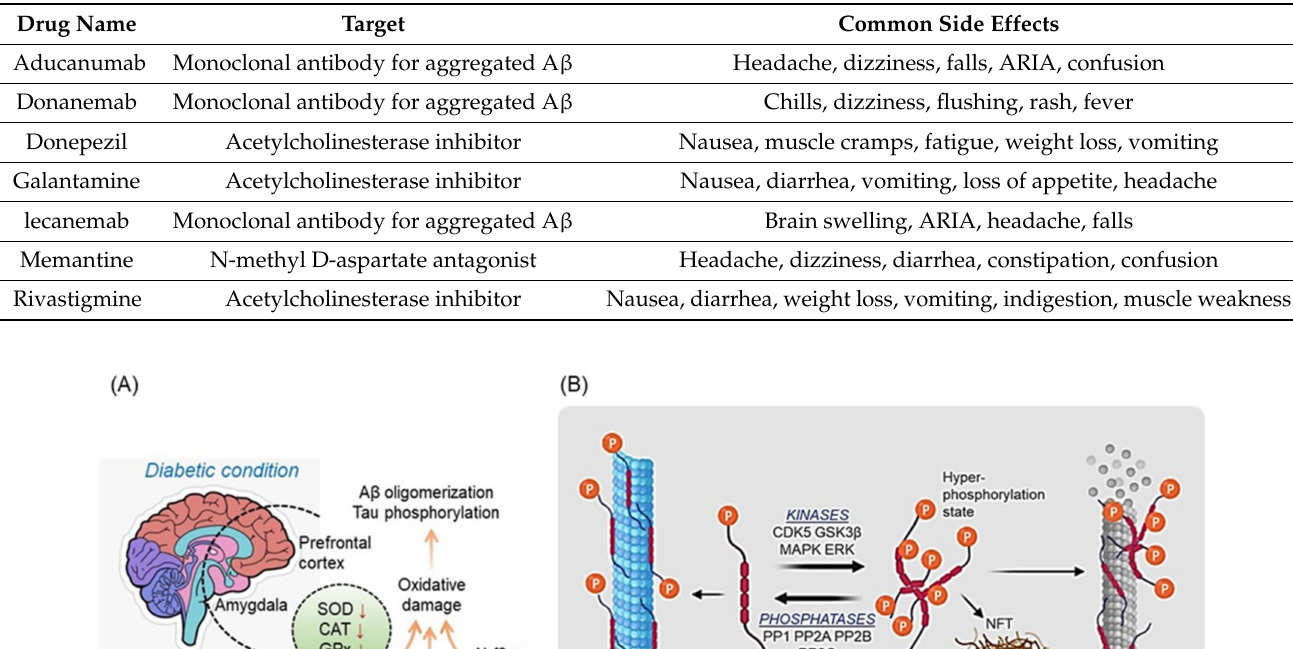
Table 2. The FDA-approved drugs for AD treatment (ARIA; amyloid-related imaging abnormalities).